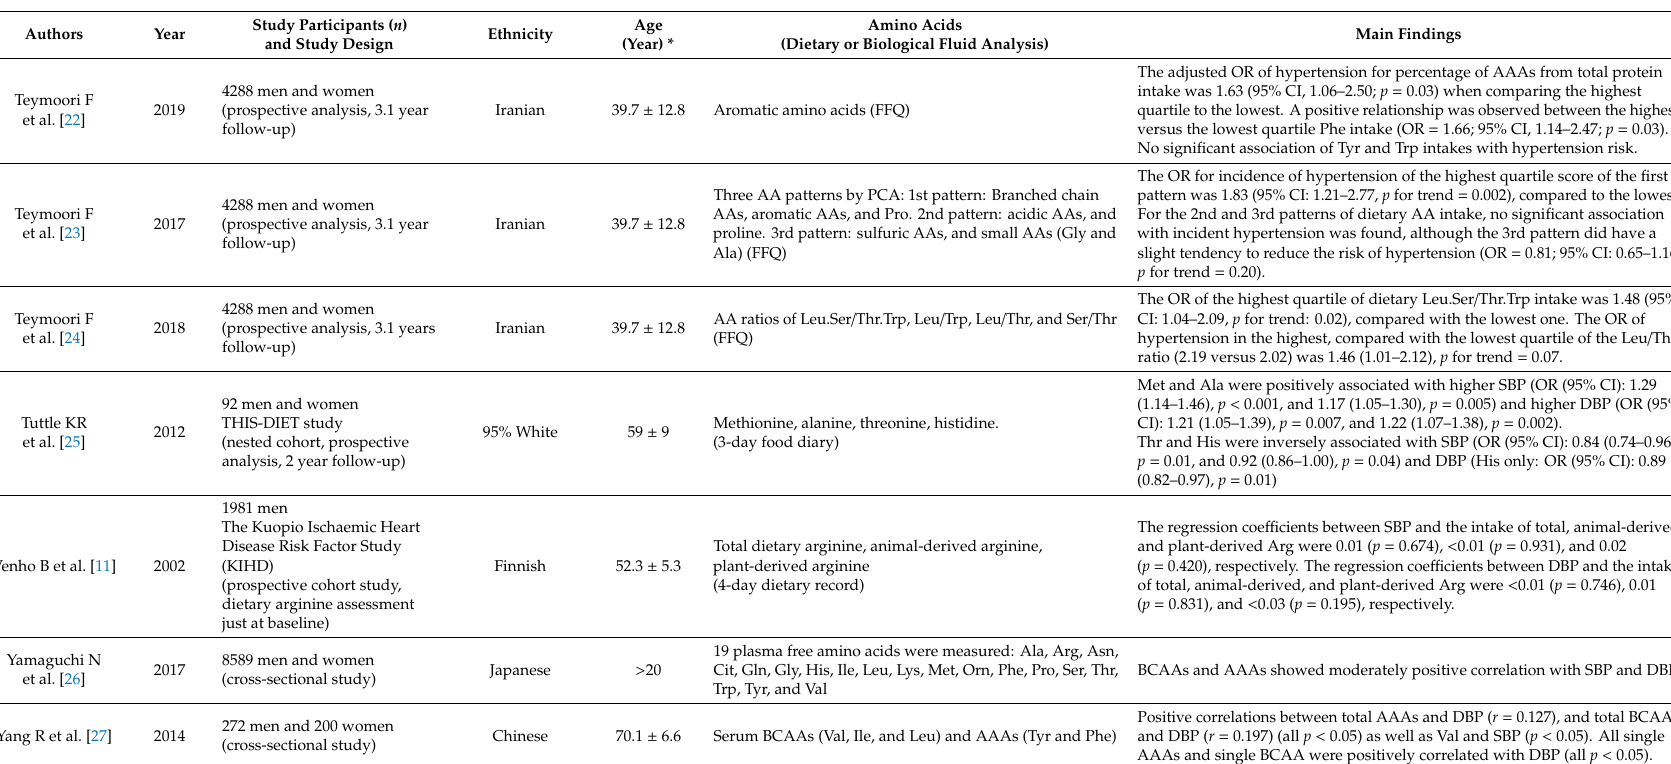
The adjusted OR of hypertension for percentage of AAAs from total protein intake was 1.63 (95% CI, 1.06–2.50; p = 0.03) when comparing the highest